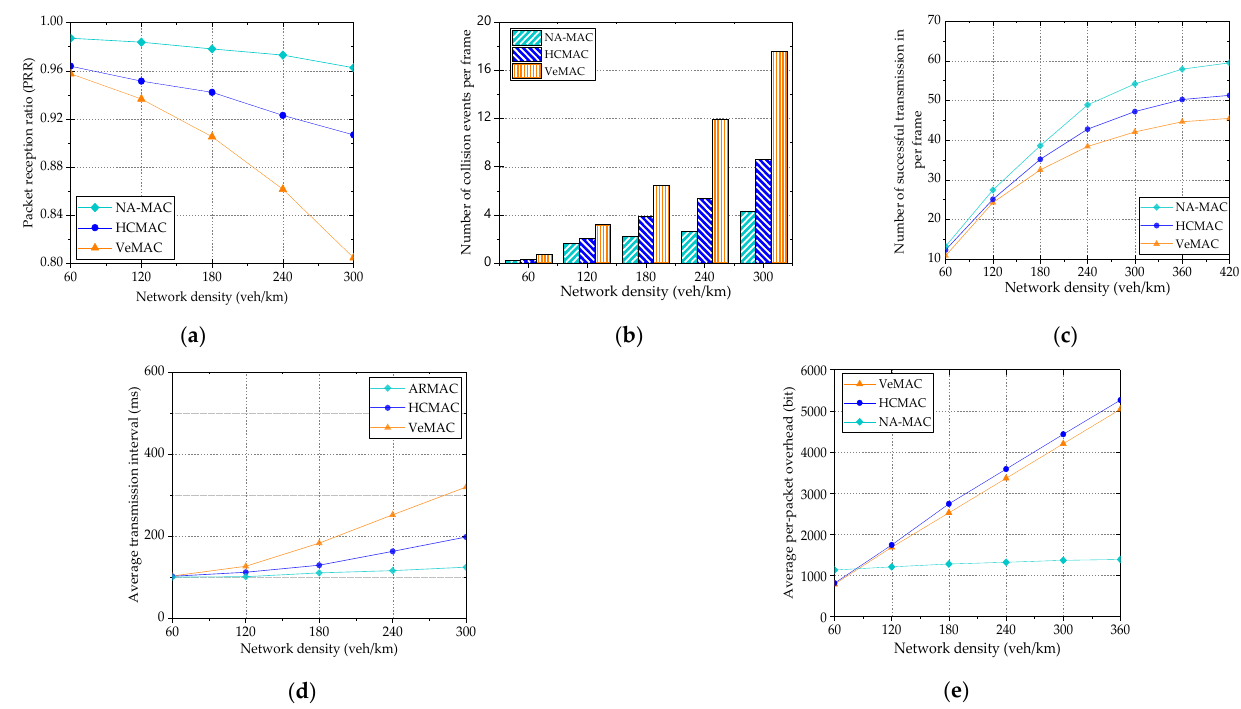
Figure 8. Simulation results: ( a ) packet reception ratio vs. network density; ( b ) number of collision events vs. network density; ( c ) number of successful transmissions per frame; ( d ) average transmission interval; ( e ) average per-packet overhead vs. various protocols.